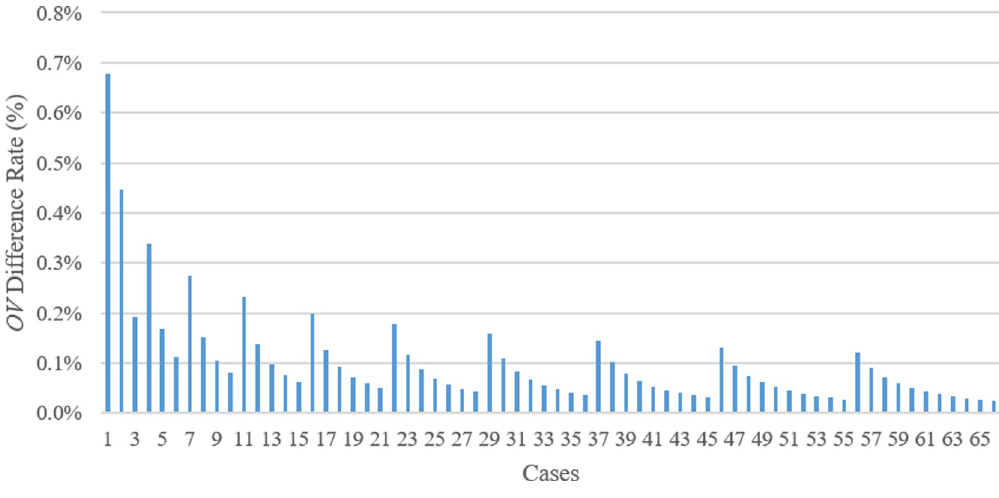
Fig 16. Comparison between WA and WOA in terms of OV difference